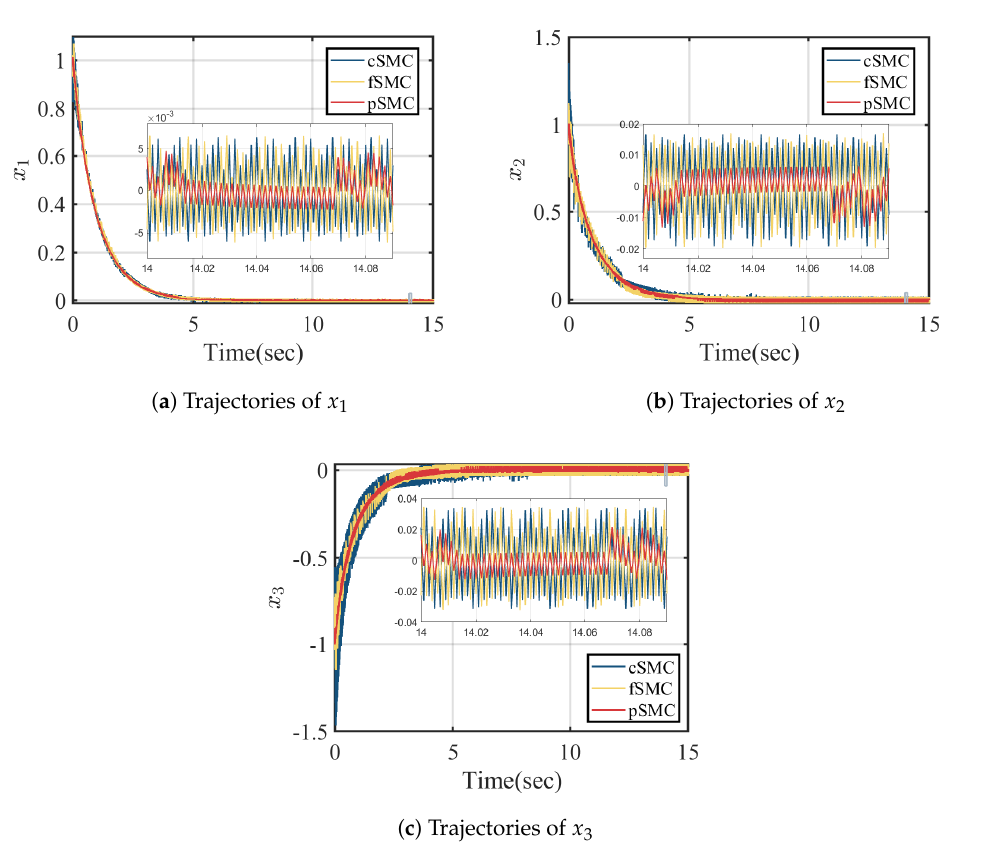
Figure 5. The trajectories of state variables x 1 , x 2 and x 3 when ρ b = 0.9: cSMC (Blue solid line), fSMC (Yellow solid line) and pSMC (Red solid line).